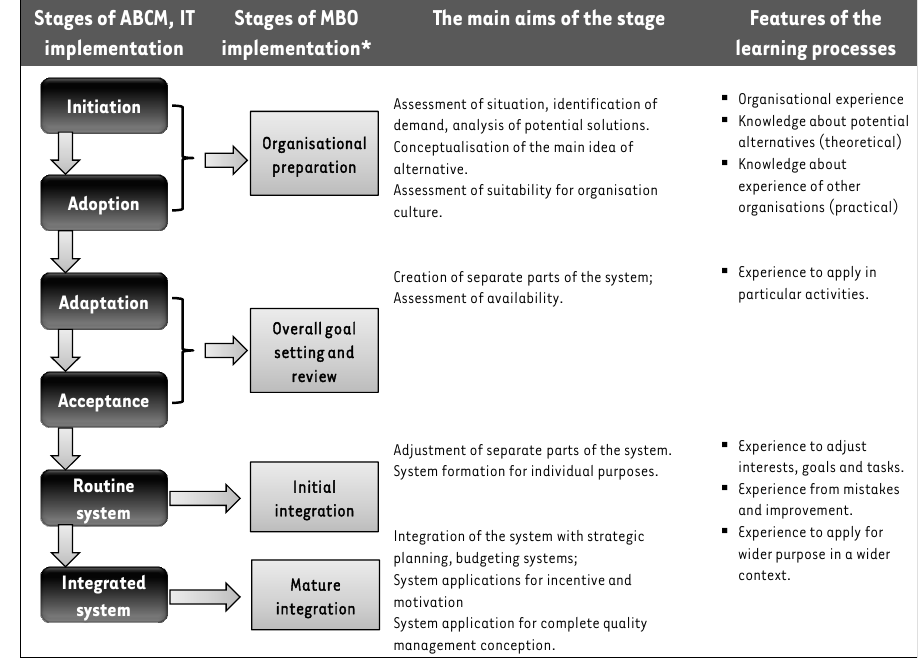
TABLE 1: Comparison of ABCM, IT, MBO implementation stages Stages of ABCM,